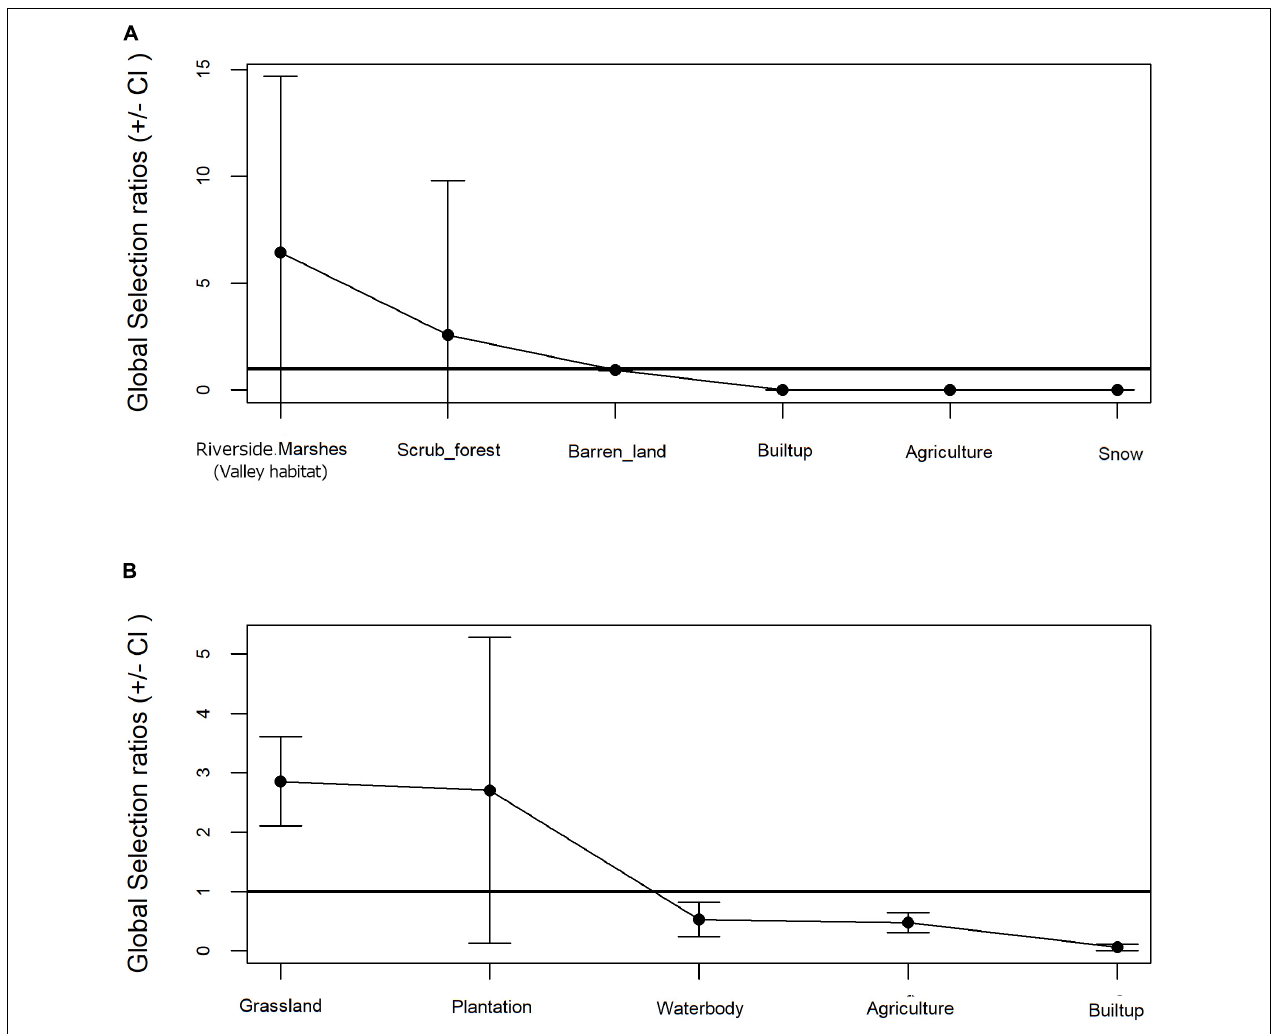
FIGURE 4 | Land use proportion in relation to availability vs. used based on Manly’s test for (A) Woolly wolf and (B) Indian wolf.